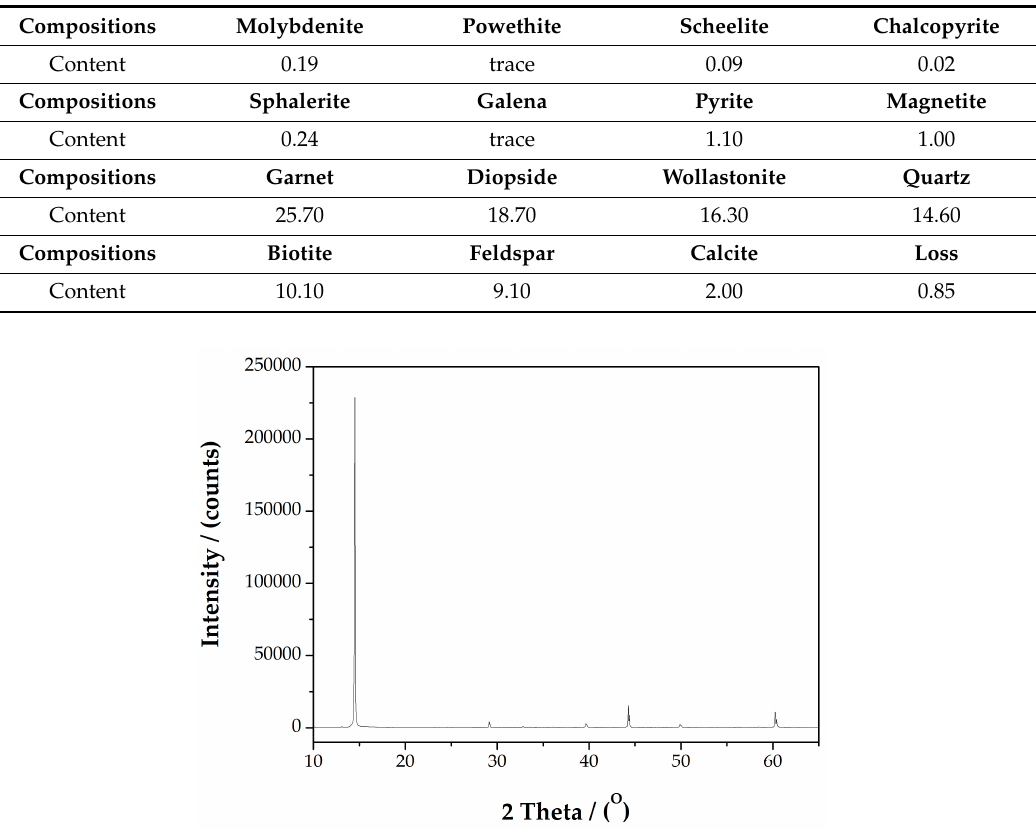
Table 2. The mineralogical composition of the actual Mo ore (wt %).